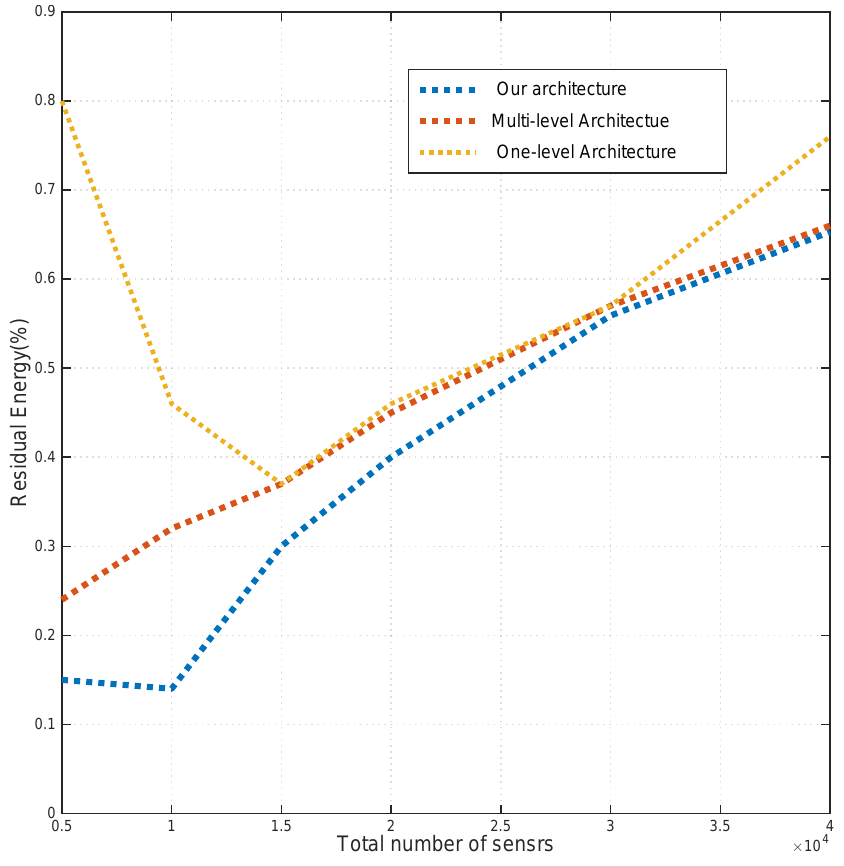
Figure 13. Average residual energy rate according to LEACH.